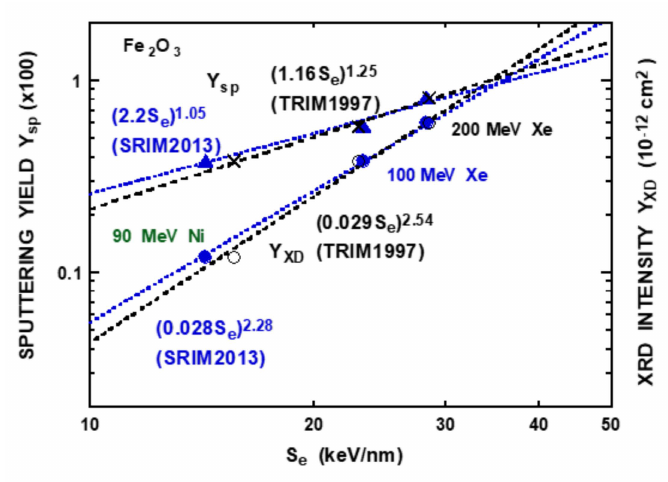
Figure 6. XRD dgradation per unit fluence Y XD of polycrystalline Fe 2 O 3 films ( • , o) and sputtering yield Ysp ( (cid:78) , x) as a function of the electronic stopping power (S e ) in keV/nm. Power-law fits are indicated by dashed lines and S e is calculated using SRIM2013 ( • , (cid:78) ) and TRIM1997 (o, x): ( • ) Y XD = (0.028 S e ) 2.28 (SRIM2013), (o) Y XD = (0.029S e ) 2.54 (TRIM1997), ( (cid:78) ) Y sp = (2.2 S e ) 1.05 (SRIM2013) and (x) Y sp = (1.16 S e ) 1.25 (TRIM1997). Sputtering data and power-law fit to the sputtering yields